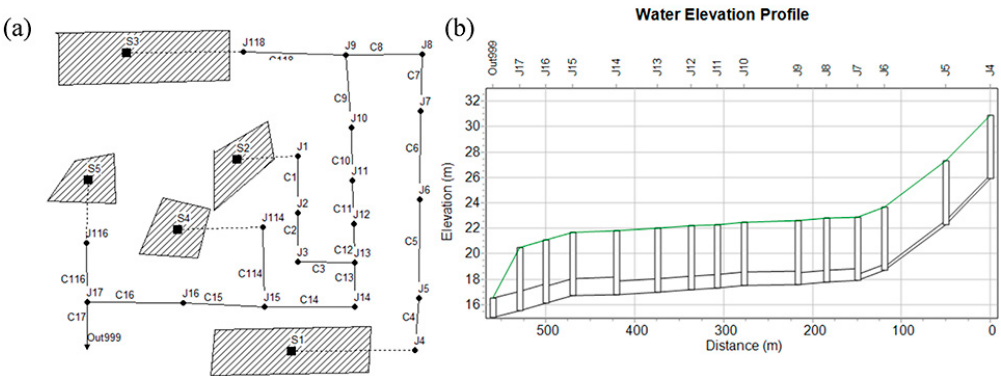
Figure 4. Drainage system configuration: ( a ) structure of the drainage system; ( b ) schematic view of the pipe diameter, length, and depth (Data from Bennis et al. and Cat et al. [28,29]).